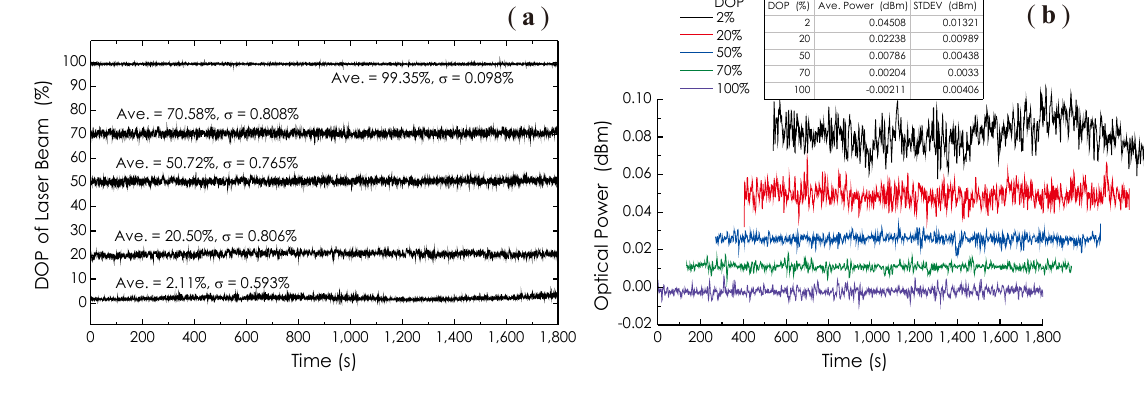
Figure 10. Measured results on the long-term stabilities of: ( a ) DOP; and ( b ) the optical power of the laser beam at different DOP